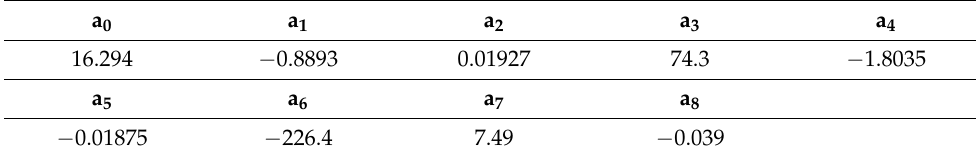
Table 4. Coefficients of the model for Equation